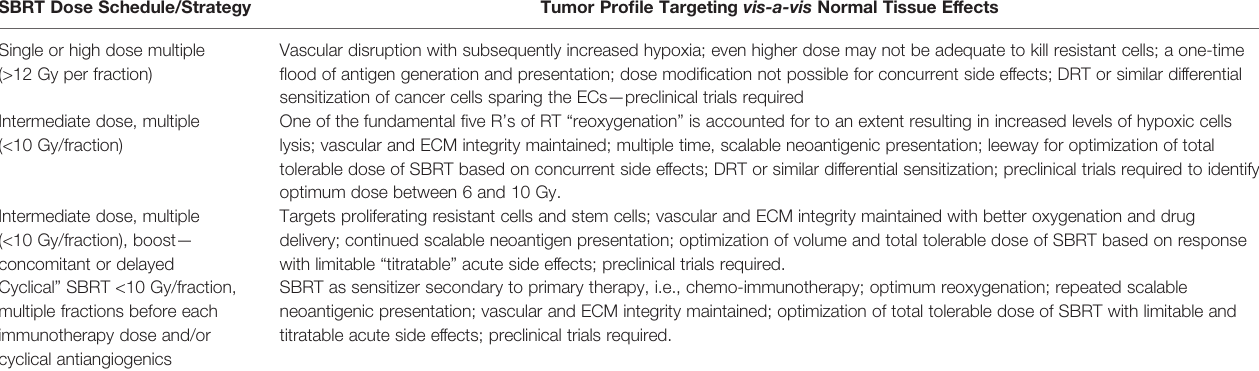
TABLE 2 | Proposed SBRT dose schedule approaches with or without harmonized combination therapies matching the tumor pro fi le of the vascular-immuno- phenotypic (VIP) model. SBRT Dose Schedule/Strategy Tumor Pro fi le Targeting vis-a-vis Normal Tissue